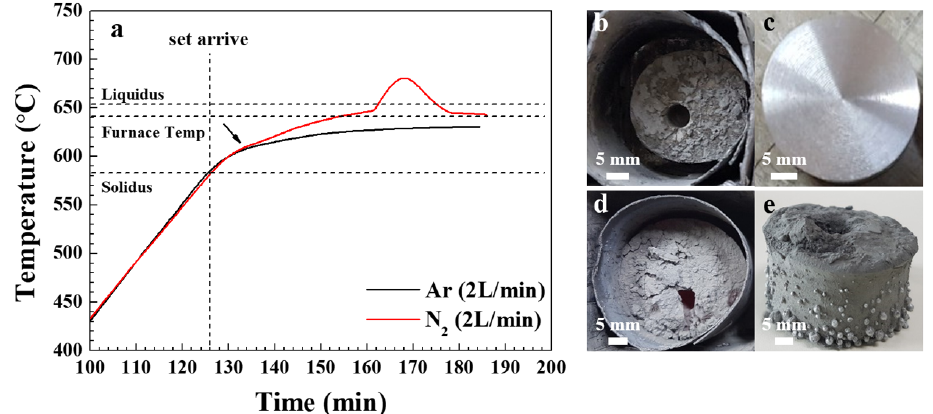
Figure 1. (a) The temperature variation of 20 vol.% SiC (40 μ m)/Al 6061 composites during heating at Figure 1. ( a ) The temperature variation of 20 vol.% SiC (40 µ m) / Al 6061 composites during heating at a a set temperature of 640 °C under nitrogen and argon atmospheres (flow rate: 2 L/min); (b–e) settemperatureof640 ◦ Cundernitrogenandargonatmospheres(flowrate: 2L / min); ( b–e )Photographic images of the composites produced under an atmosphere of nitrogen ( b , c ) and argon ( d , e ) in the air-cooled crucibles ( b , d ) and after lathe working ( c